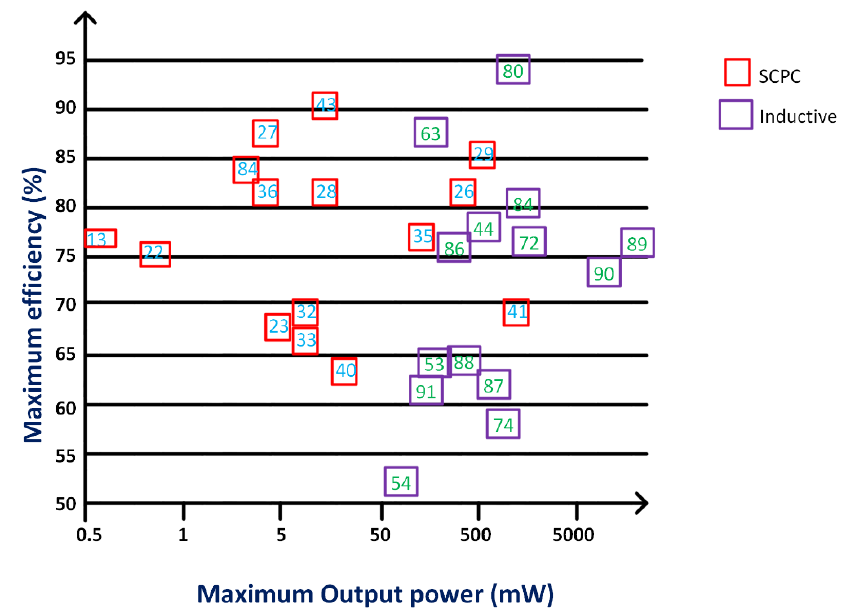
Figure 14. Maximum output power vs. peak efficiency of different designs in the literature for inductive and switched-capacitor converters.